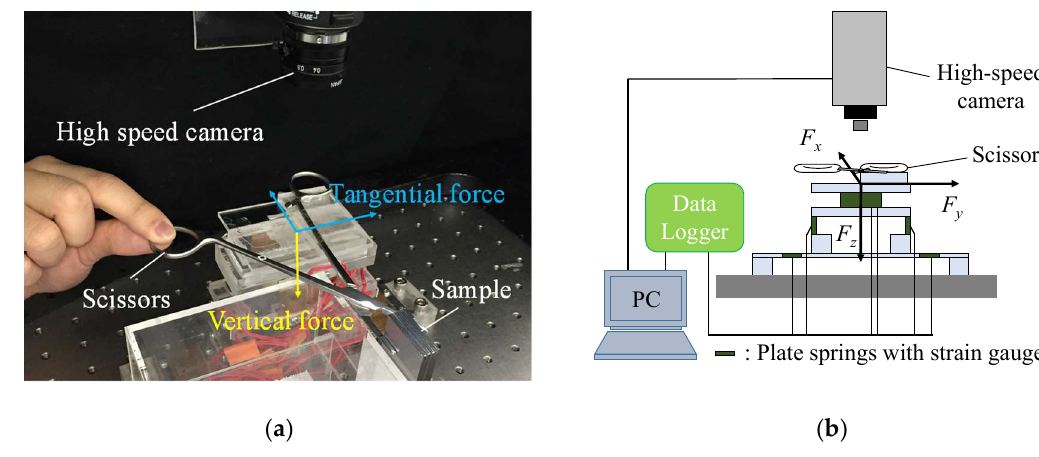
Figure 2. ( a ) A photograph and ( b ) diagram of the mechanical evaluation system used for the simultaneous measurement of the motion and force properties during grasping/cutting processes.